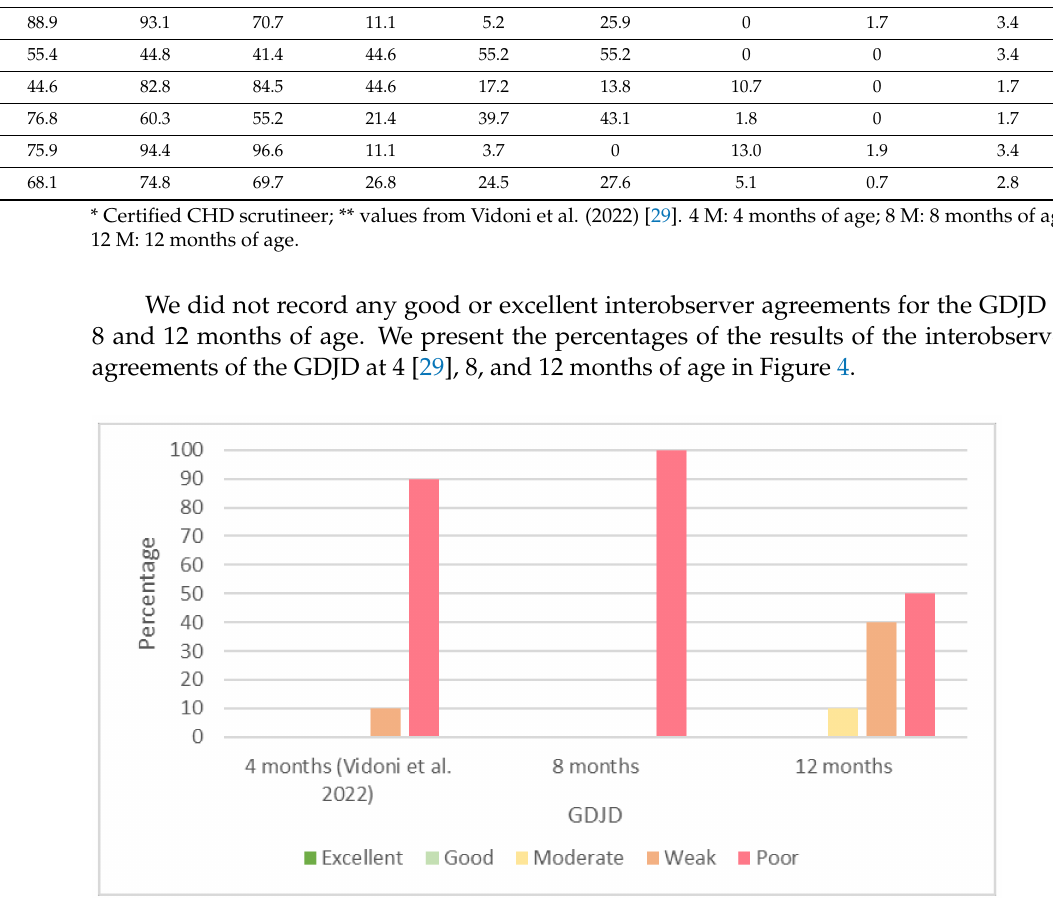
Figure 4. Percentages of results of interobserver agreements (Cohen’s kappa coefficient) for grading of degenerative joint disease (GDJD) at 4 [29], 8, and 12 months of